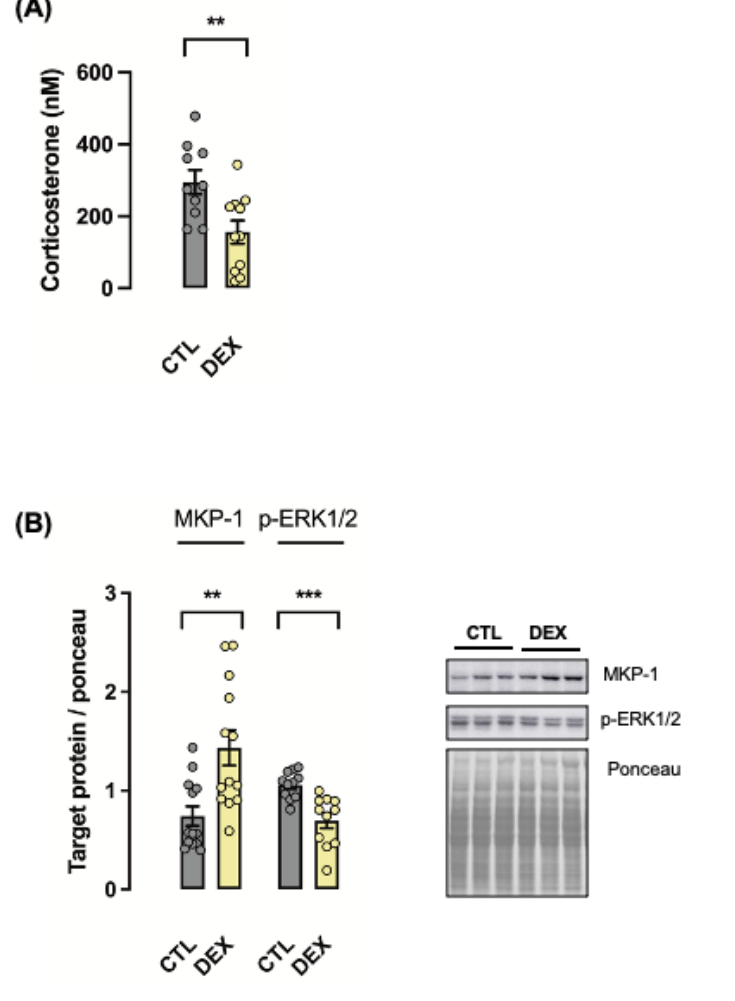
Figure 2. Maternal dexamethasone treatment suppressed fetal hypothalamic – pituitary – adrenal (HPA) axis and increased MKP1 activity in the offspring liver in early life. Blood samples were collected at the first day of life to measure corticosterone levels ( A ). Liver fragments were removed from rats born to DEX-treated mothers (DEX) and untreated mothers (CTL) at the first day of life and processed for Western blot detection of MAPK-1 (Mitogen-Activated Protein Kinase 1) and its target phosphorylated ERK1/2 (Extracellular Signal-Regulated Kinase 1 and 2). Band intensities were normalized by the signal from Ponceau staining. Data are presented as the mean ± SEM; ** p < 0.01; *** p < 0.0001 vs. CTL. In ( A ), CTL: n = 10; DEX: n = 11. In ( B ), n = 12 for both groups.